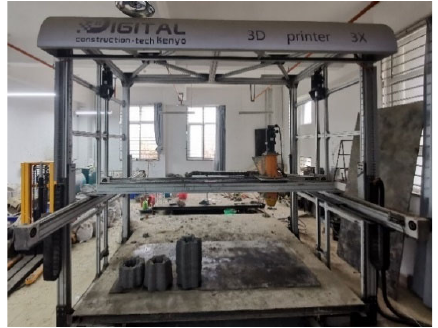
Figure 8. The 3D concrete printing system in the experiment. Table 2. Data collected in the experiment. Table 2. Data collected in the